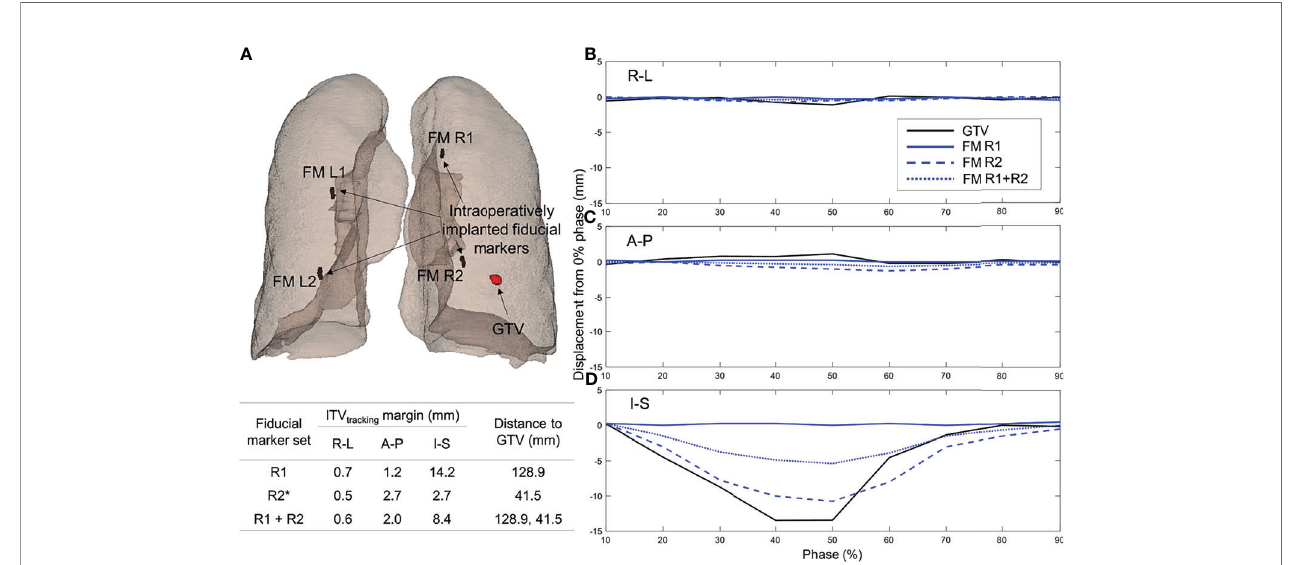
FIGURE 2 | ITV tracking determination results: (A) illustrative example of the processing to optimally select a fi ducial marker (FM) set with a minimal ITV tracking margin by comparing the motions of the GTV and all possible sets of the fi ducial markers, (B – D) histograms of the ITV tracking margins (i.e., the motion differences between the gross tumor volume and optimally selected FM set) calculated across 42 lung lesions from 17 patients in the (B) R-L, (C) A-P, and (D) I-S directions, respectively. ITV, internal target volume; R-L, right-left; A-P, anterior-posterior; I-S, inferior-superior; CK, CyberKnife.